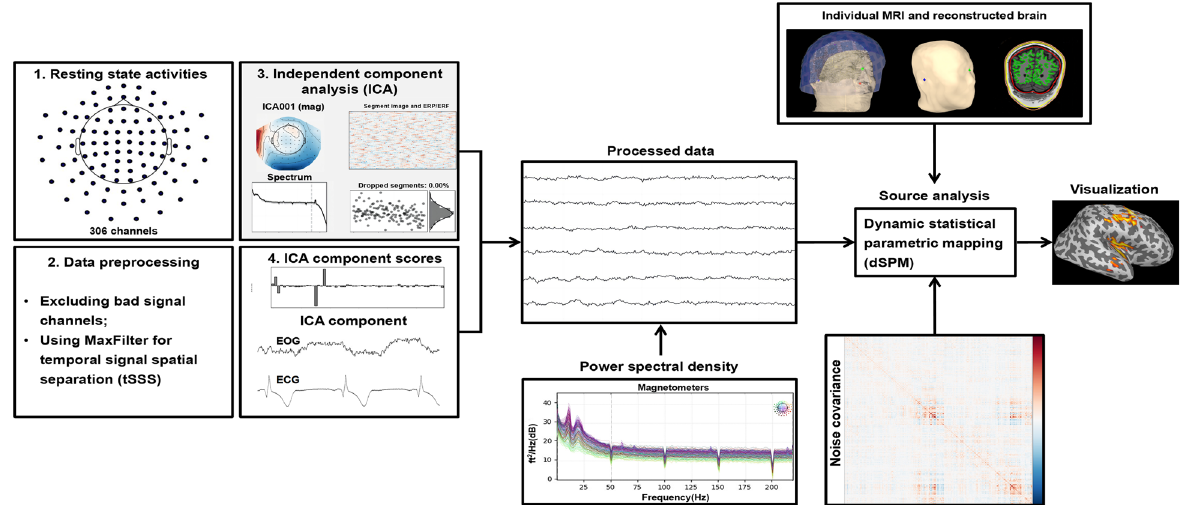
Fig. 1 The pipeline of resting-state magnetoencephalographic spectral and source